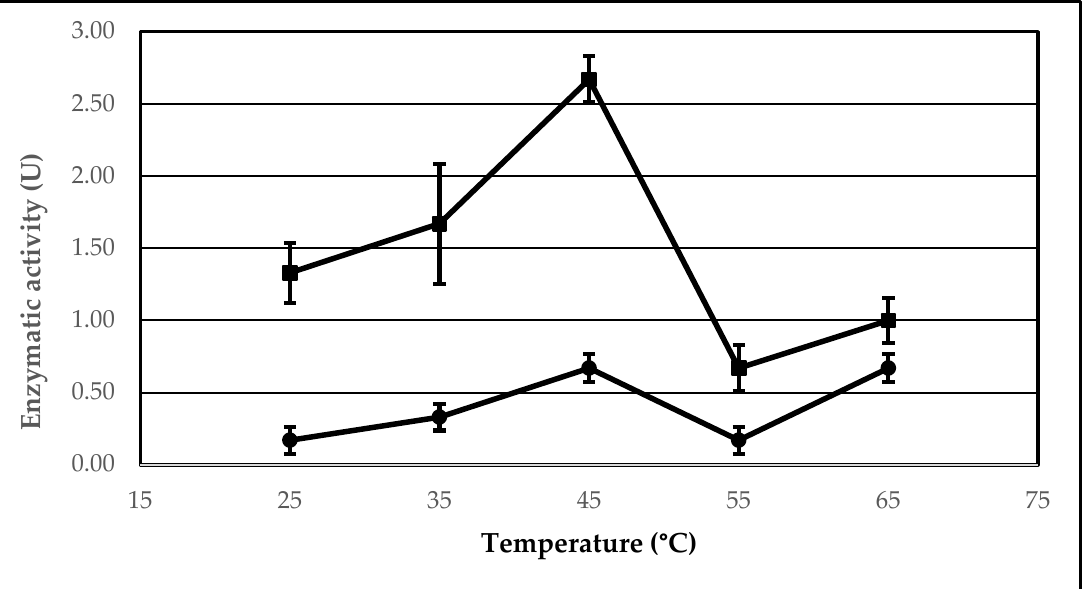
Figure 3. Effect of temperature on the activity of AA-ANL in free form (circles) and immobilized onto IB-150A support (squares). Reaction mixture: free AA-ANL (5.0 ± 0.2 mg) or AA-ANL immobilized on IB-150A beads, phosphate buffer (100 mM, pH 7.4), and an emulsion containing equal volumes of peanut oil and gum arabic suspension. The mixture was incubated for 30 min. The error bars represent the standard deviations of the mean.